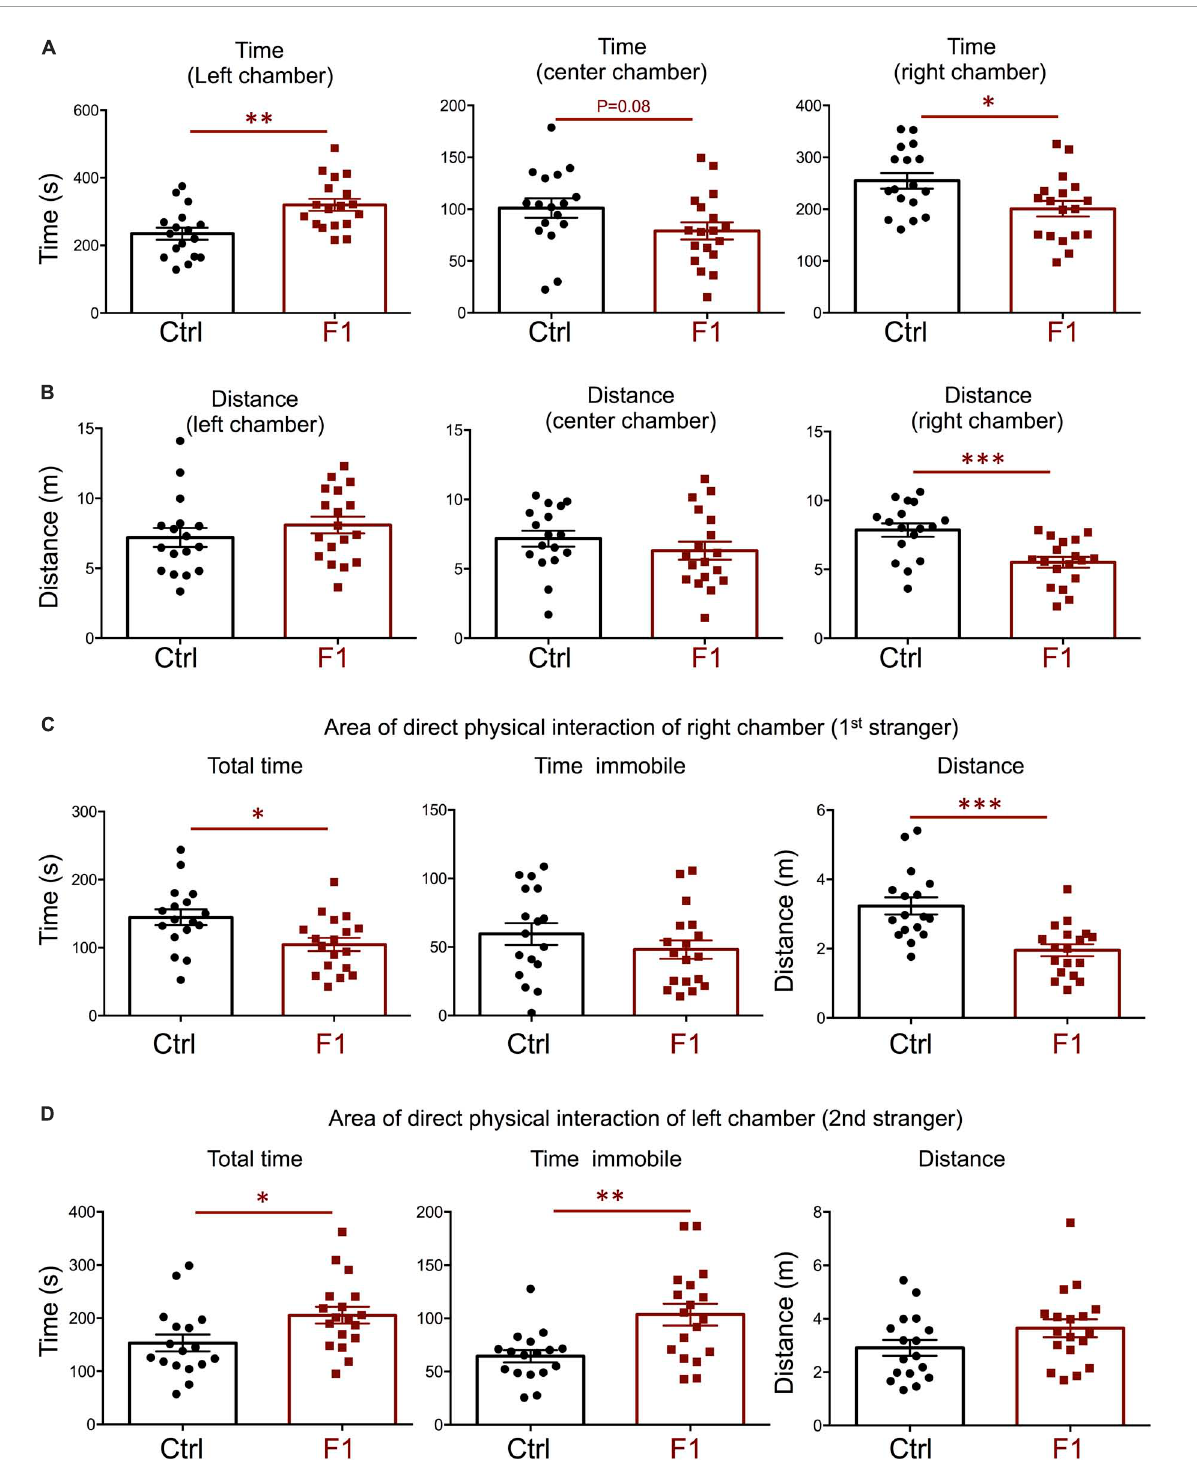
FIGURE8 Interest in social novelty of F1 generation females. (A–C) Second trial of the three-chamber social box test, after first stranger is introduced in the right chamber. (A) Time spent by the test mouse in each chamber. (B) Distance traveled by the test mouse in each chamber. (C) Total time, time immobile, and distance traveled by the test mouse in the area immediately around the 1st stranger in the right chamber. (D) Total time, time immobile, and distance traveled by the test mouse in the area immediately around the 2nd stranger in the left chamber. Each point represents a different mouse tested at approximately 18 weeks of age ( n = 17, 19) and mean ± SEM are shown. Experimental mice from each group represent 4–6 different litters and data represent two animal cohorts that were generated and tested at different dates. ∗ , ∗∗ , and ∗∗∗ indicate P < 0.05, 0.01, and 0.001, respectively, as determined by the Student’s t